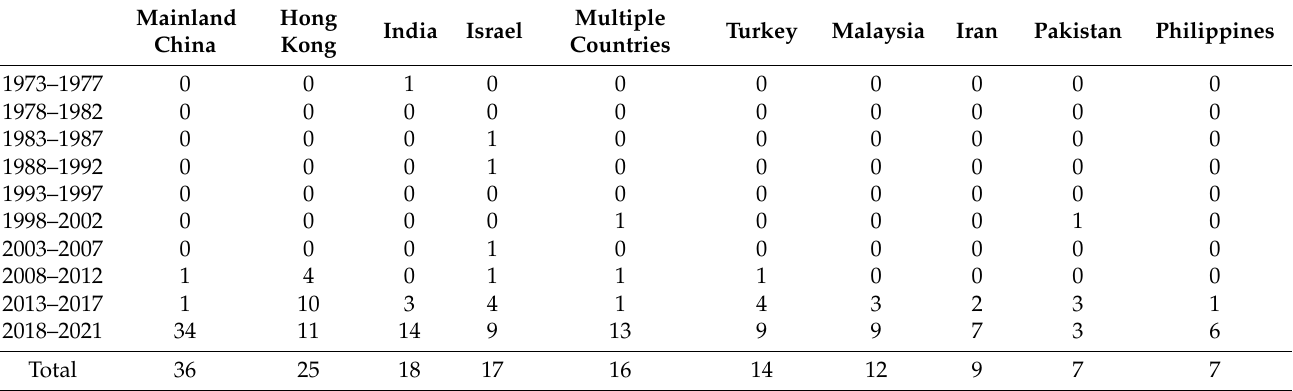
Table 1. Trend of Data Location by Five-Year Interval during